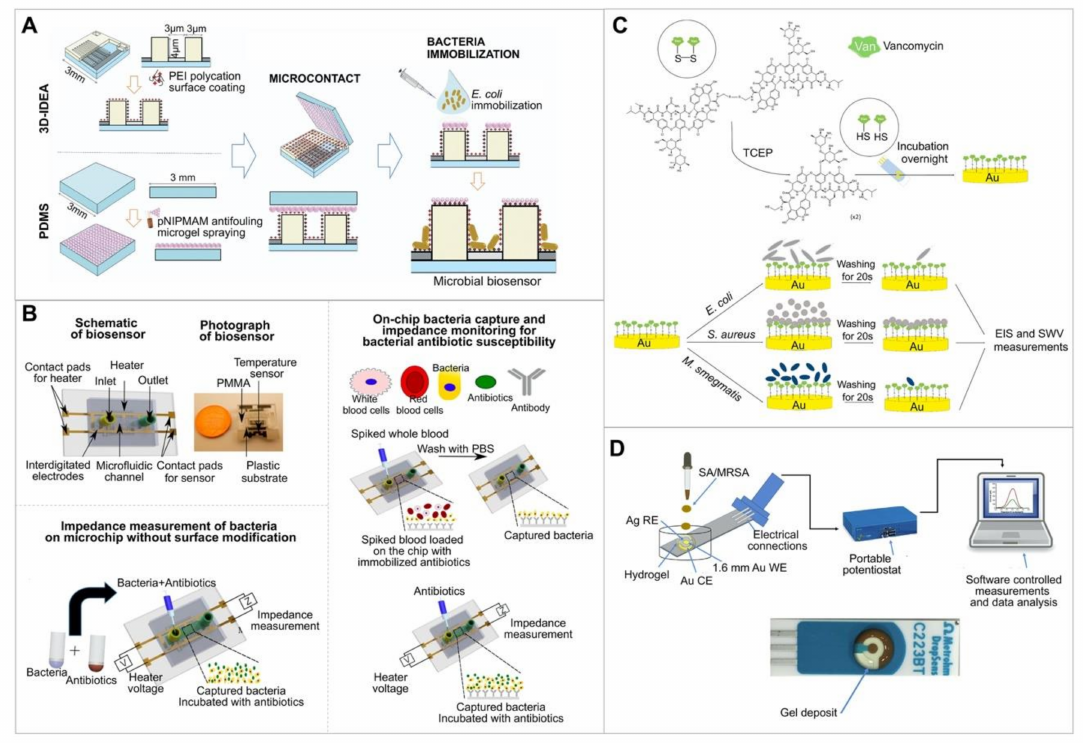
Figure 2. Electrochemical antibiotic susceptibility testing (AST) strategy based on the detection of the change in impedance caused by cell lysis: ( A ) Bacterial cell–immobilized 3D interdigitated electrode array (3D-IDEA) impedimetric transducer for the AST of Escherichia coli against ampicillin. Adapted with permission form [51]. Copyright 2019 RSC; ( B ) Bacterial cell–immobilized plastic microchips with printed electrodes for AST of E. coli and methicillin-resistant Staphylococcus aureus (MRSA) against ampicillin erythromycin, ciprofloxacin, methicillin, daptomycin, and gentamicin. Adapted with permission form [52]. Copyright 2017 American Chemical Society; ( C ) Antibiotic- immobilized screen-printed gold electrode (SPGE) for the AST of S. aureus against vancomycin. Adapted with permission form [53]. Copyright 2021 Talanta; ( D ) Hydrogel-covered three electrodes for the AST of S. aureus (SA) and MRSA against amoxicillin and oxacillin. Adapted with permission form [54]. Copyright 2021 Biosensors and Bioelectronics. PEI, polyethyleneimine; pNIPMAM, poly N- isopropyl methacrylamide; PDMS, polydimethylsiloxane; PMMA, poly methyl methacrylate; TCEP, tris(2-carboxyethyl)phosphine hydrochloride; EIS, electrochemical impedance spectroscopy; SWV, square wave voltammetry; RE, reference electrode; CE, counter electrode; WE, working